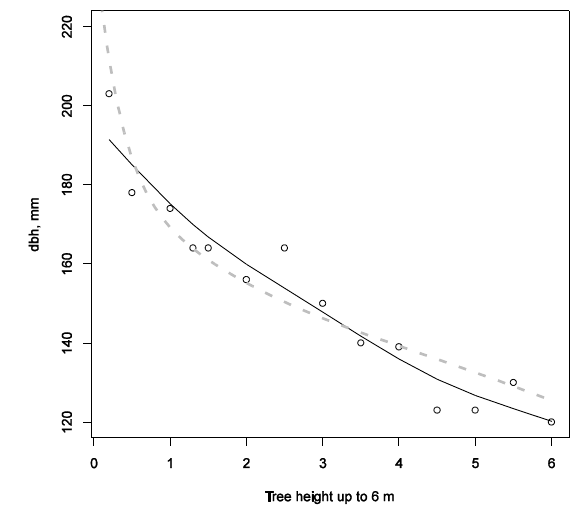
Figure 7. TLS measured stem diameters (circles), spline stem curve predicted from TLS (black line) and Laasasenaho’s stem curve predicted from dbh (dashed grey) for a Scots pine with dbh of 164 mm and height of 15.1